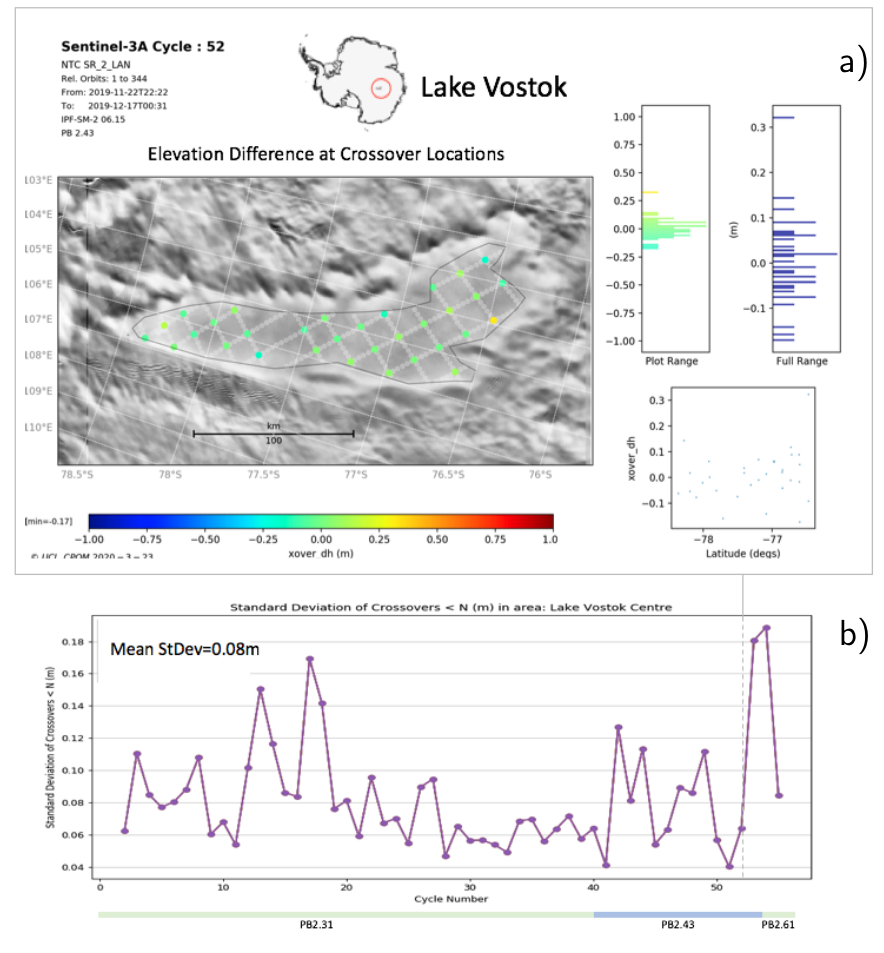
Figure 33. OCOG elevation differences at single cycle orbit crossover locations over sub-glacial Lake Vostok. ( a ) Single cycle example (from Cycle 052), ( b ) S3A mission time series of standard deviation of differences, with dashed line showing how the selected cycle fits